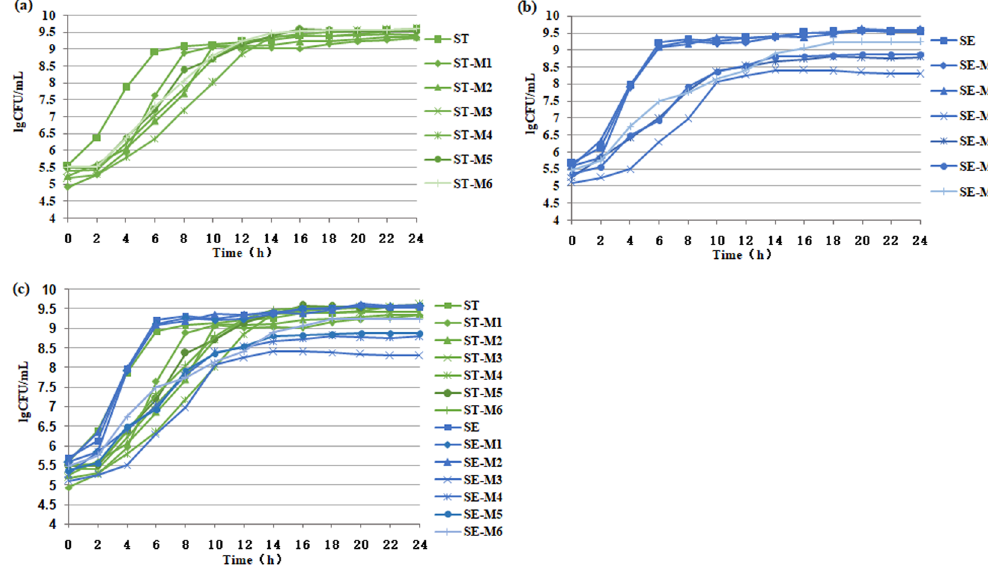
Figure 1. Bacterial growth curves of: ( a ) ST and its mutants; ( b ) SE and its mutants, and; ( c ) ST, SE and their corresponding mutants in antibiotic-free LB broth. Results are the mean of three independent experiments.